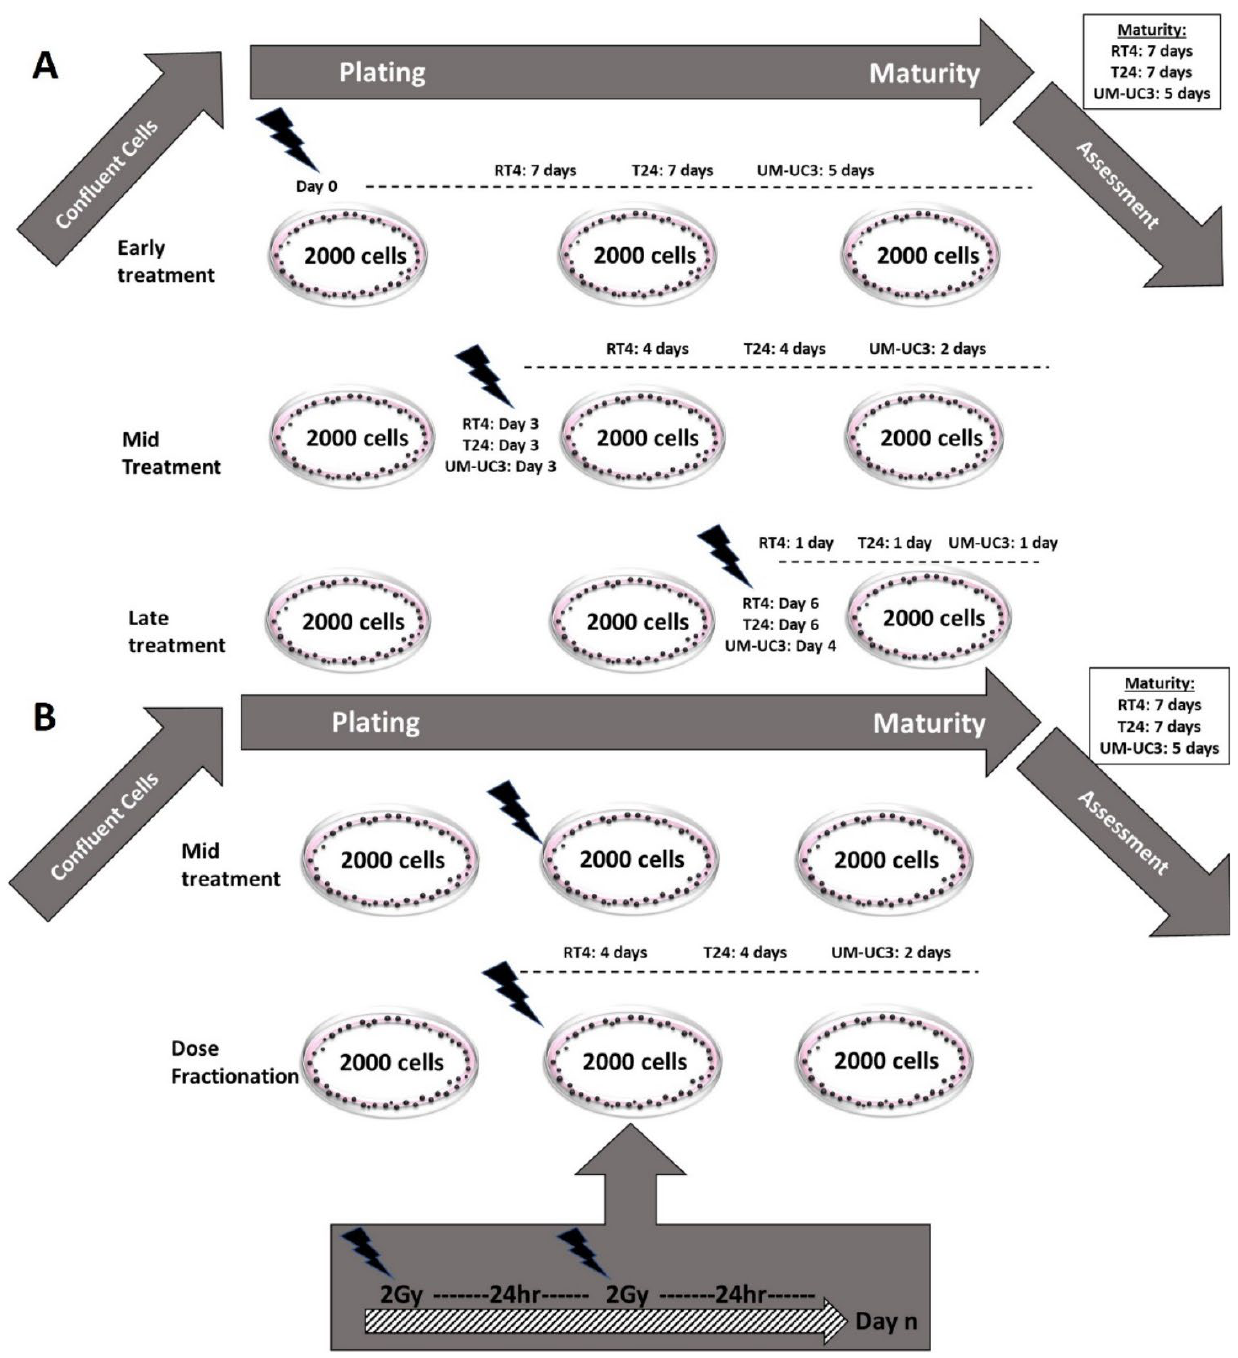
Figure 1. Protocols illustration ( A ) Schematic illustrating the 3 different treatment protocols per- formed. ( B ) Schematic representing the dose fractionation (DF) treatment protocol (mid treatment protocol was added for